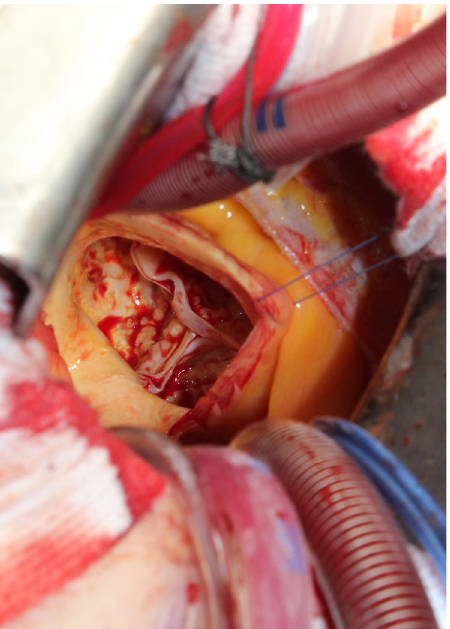
Fig. 8 - In sutured prostheses, we prefer to implant the valve with 3 running sutures.